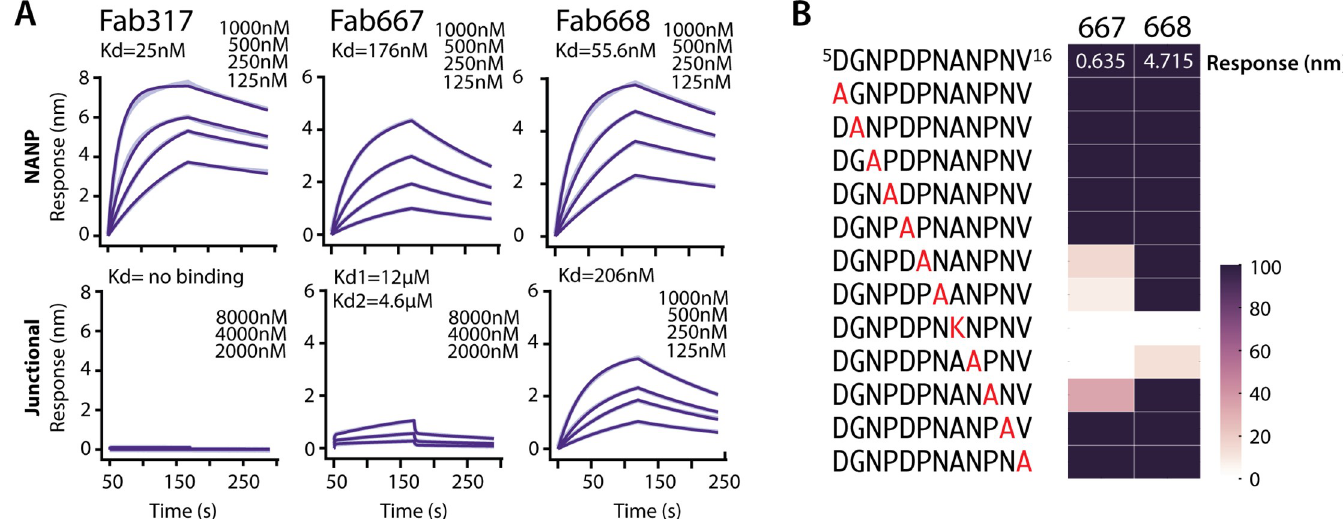
Fig 1. Binding studies to assess dual specificity for the junctional and NANP epitopes. ( A ). Biolayer Interferometry (BLI) was used to measure the kinetics of binding for Fab317, Fab667 and Fab668 to either the NPNANPNANPNANPNA (NANP) peptide or the KQPADGNPDPNANPNV (junctional) peptide. Binding curves are shown in light purple (wider lines) and fits are shown in dark purple (thinner lines). As the fits to the data are very good, the binding curves and fits overlap. ( B ) Alanine scan for the junctional peptide using BLI. The binding response (amplitude) is normalized to the wild-type junctional peptide. Binding is shown as a gradient from dark purple (native binding) to white (no